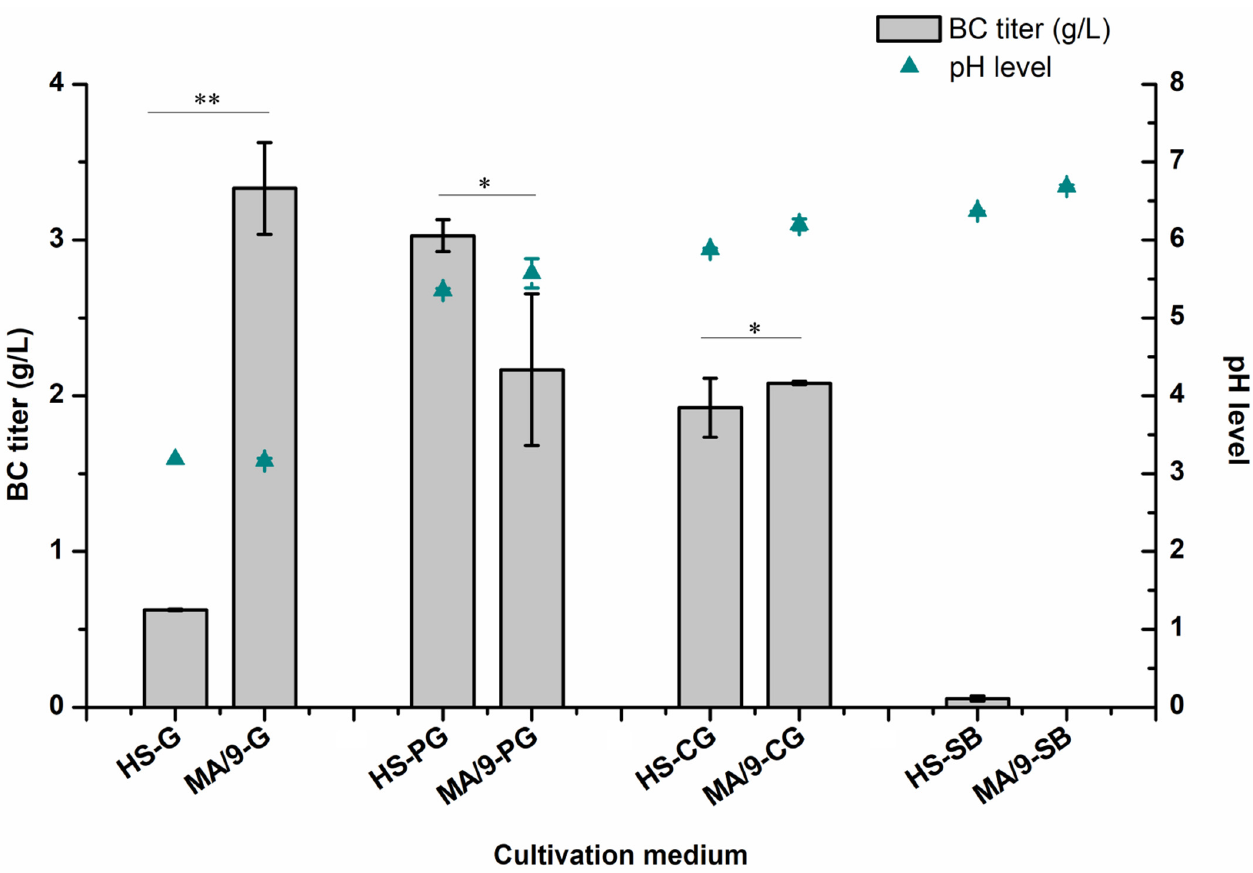
Figure 2. Bacterial cellulose (BC) production (bars), and pH (line) plots from static cultivations in HS and MA/9 growth media supplemented with 2% glucose (G), pure glycerol (PG) and crude glycerol (CG). Substrate blank (SB) was included to identify the contribution of medium components (yeast extract and peptone and casein amino acids in HS medium and MA/9 medium, respectively) towards BC production. The pH levels of the medium after the cultivation period are presented as scattered plots (Cyan triangles). The data points represent the mean experimental results and standard deviations from duplicate cultivations. In some cases, the error bars are smaller than the symbol. Statistical differences between the results of BC production in HS and MA/9 media containing similar growth substrate were analyzed using Two sample t-test with equal variances. Samples with p > 0.05 and p < 0.05 are represented by * and **, respectively.